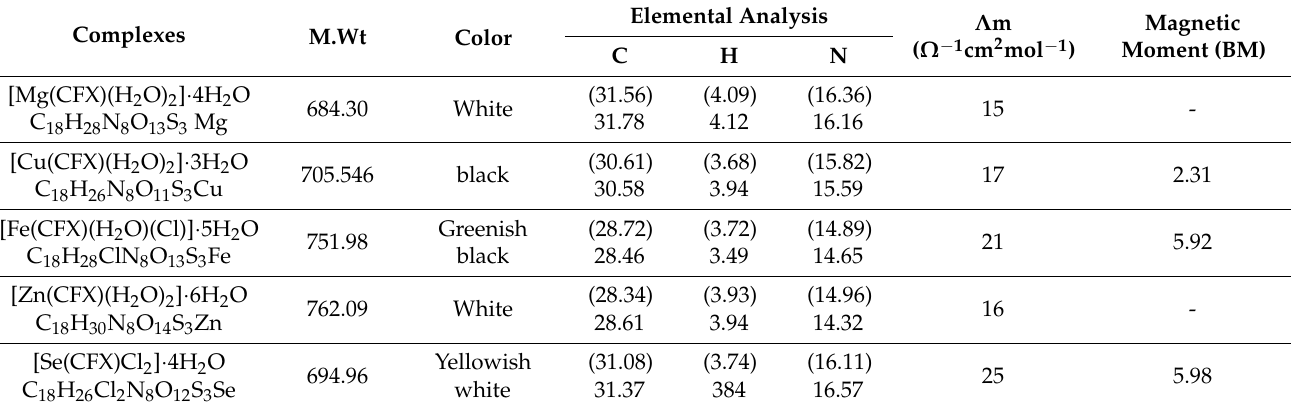
Table 2. Elemental analysis and conductivity measurements for ceftriaxone